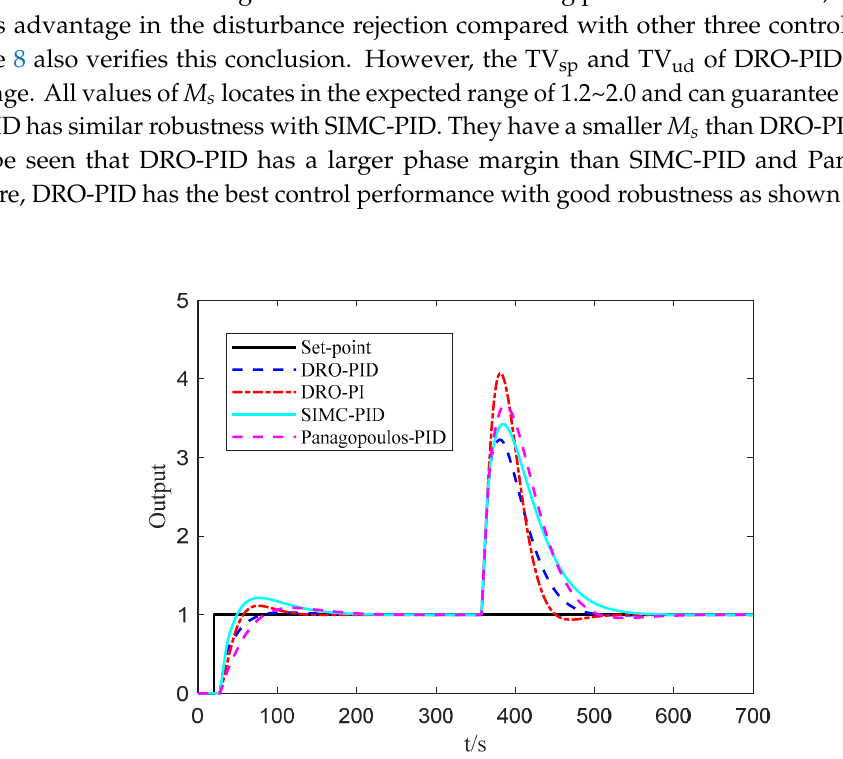
Figure 12. The output response of the step set-point and input disturbance for Example 3. Processes 2019 , 7 , x FOR PEER REVIEW